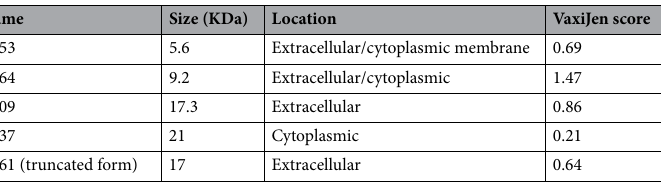
Table 1. Name, size, cell localization and VaxiJen score of candidate proteins that were successfully